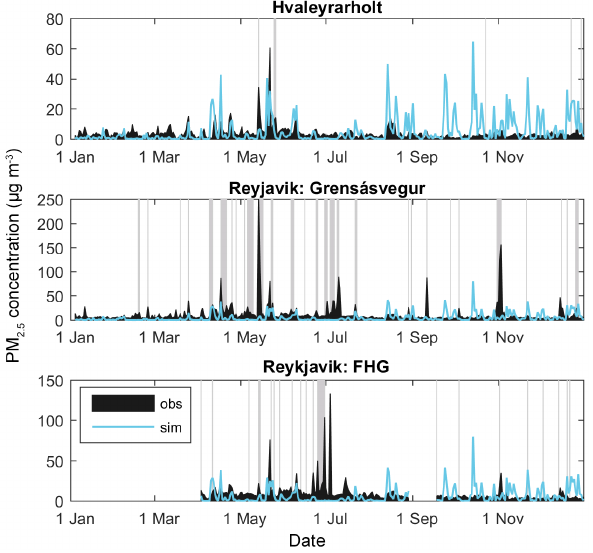
Figure 3. Daily mean PM 2 . 5 concentrations (µgm − 3 ) as observed (black) and modelled (blue) in 2012. Shaded grey areas indicate periods with inconsistent measurements of PM 10 and PM 2 . 5 (also see Fig.